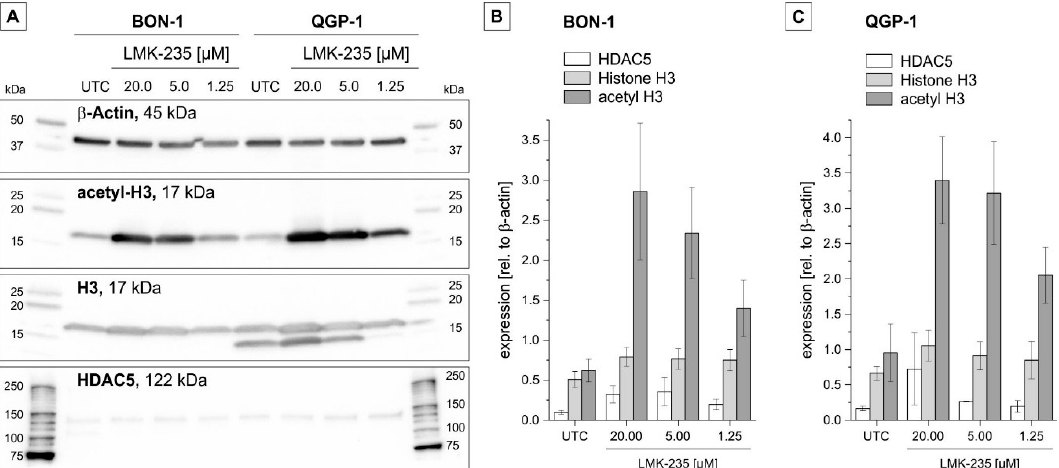
Figure 4. (Acetyl-) Histone H3 and histone deacetylase-5 protein expression following LMK-235 treatment. ( A ) Levels of acetyl-histone H3, histone H3, and HDAC5 were evaluated by immunoblotting after LMK-235 incubation for 24 h, as shown by one representative example blot. β -actin was used as a loading control for each sample. The β -actin expression corresponding to the HDAC5 blot is not shown. ( B , C ): Bars represent the semi-quantitative expression as mean values ± SEM ( n = 3) of band intensities of BON-1 ( B ) and QGP-1 ( C ) cells. Abbreviations: UTC = untreated control.